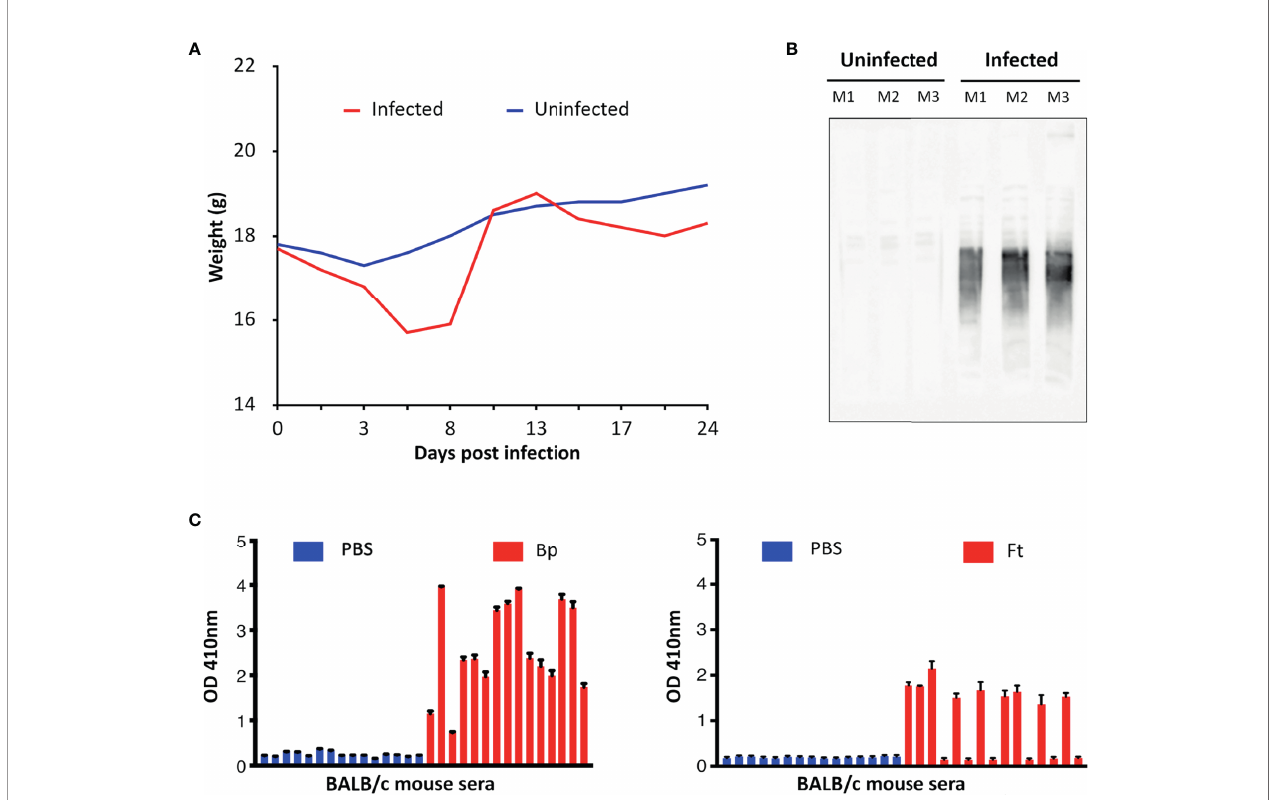
FIGURE 2 | (A) Representative course of mouse infection to obtain immune sera. Mice were infected with a sublethal dose of Bp and their weight monitored. Weight was monitored throughout the course of infection. (B) Representative Western blot of sera from infected vs uninfected mice. Bp protein lysates were analyzed by Western blotting using sera from infected and uninfected mice (Mouse 1 – 3) and bound antibodies detected using anti-mouse HRP. (C) Representative ELISA results obtained from mice infected with Bp and Ft (red) in comparison with uninfected mice (PBS-treated mice, blue). Seroreactivity of mice sera to microwells coated with corresponding pathogen lysate was assessed using protein-A/G-HRP and measuring sample absorbance (optical density). Sera of some mice infected with Ft did not yield positive results because Ft infection led to lethal outcome and mice had to be euthanized during the course of immunization. Graphs represent two technical replicates for sera collected from each mouse. Antibodies from sera with the strongest Western blot and ELISA signals were puri fi ed in this study and used to screen for immunogenic